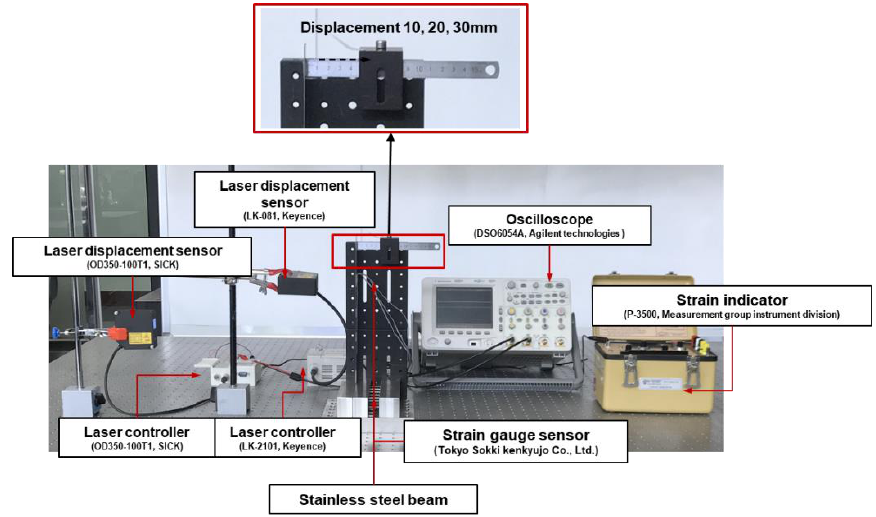
Figure 7. Test setup for displacement-to-strain transformation experiment.